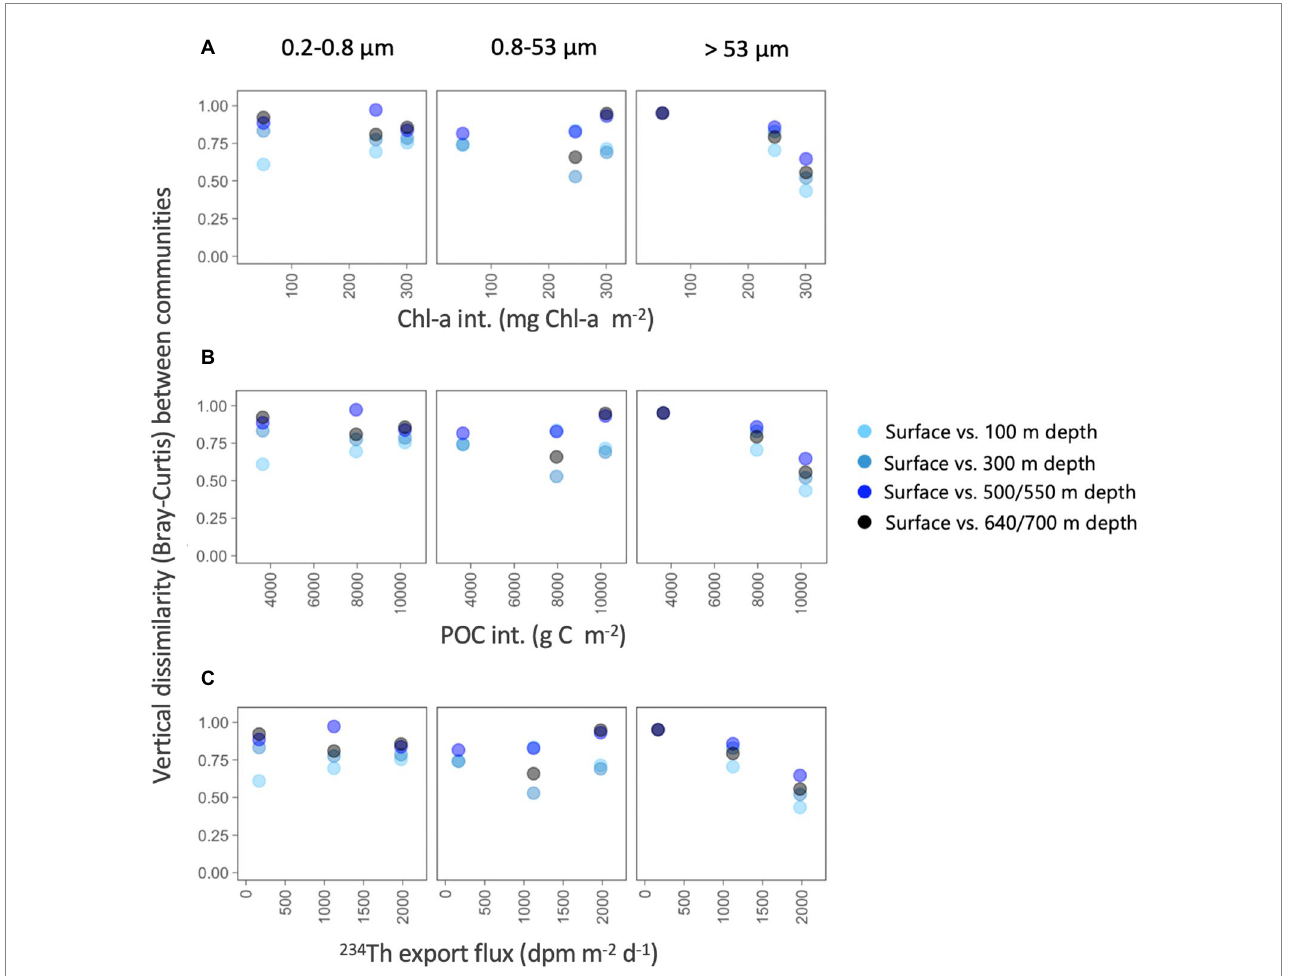
FIGURE 6 Variation in vertical taxonomic differences (Bray–Curtis dissimilarity) between surface and each of the deeper prokaryotic communities (100–700 m depth), along gradients in depth-integrated chlorophyll-a concentration, depth-integrated POC concentration and estimated 234 Th export fluxes for each of the three